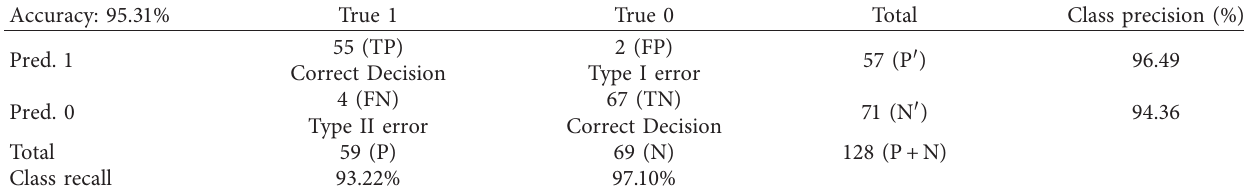
Table 4: Results of gradient boosting tree